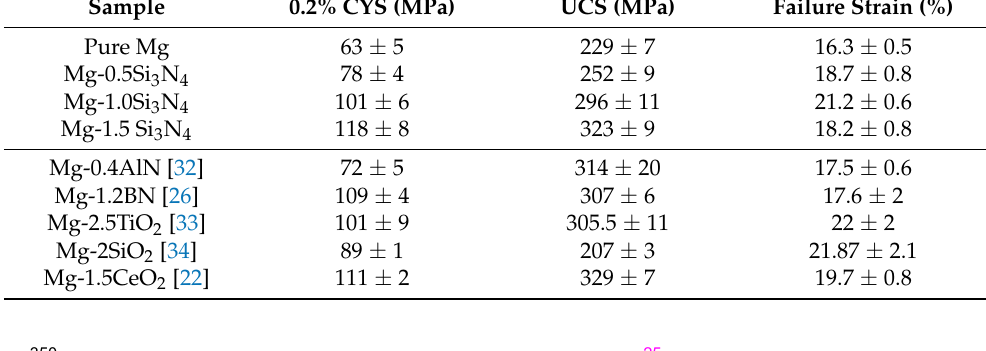
Table 1. Compression test results of the samples.